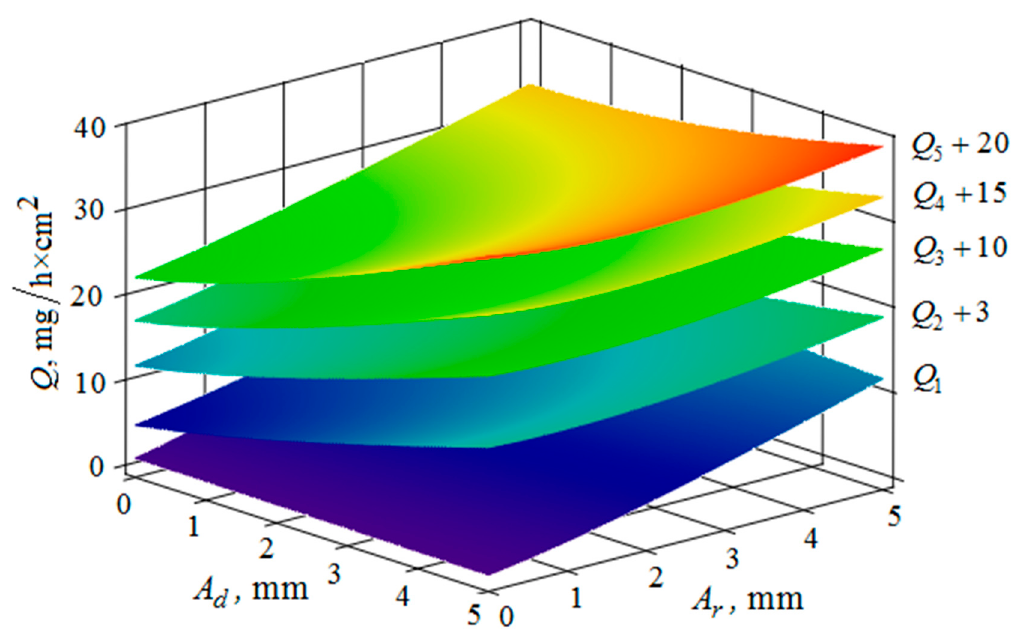
Figure 19. Dependence of the metal removal Q , mg / h · cm 2 on the amplitudes of oscillations A r , mm and A d , mm of the reservoir working surfaces and the processed part for di ff erent values of the distance between them: ( Q 1 , Q 2 , Q 3 , Q 4 , Q 5 —metal removal at Y = 40; 80; 120; 160; 200 mm); the frequencies of oscillations of the reservoir ω r working surfaces and the part ω d surface 50 Hz.